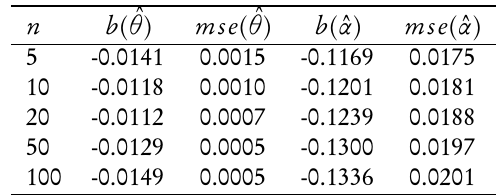
Bias and mean square error of the m.l.e.’s ( ˆ θ , ˆ α ) , for the power negative binomial distribution